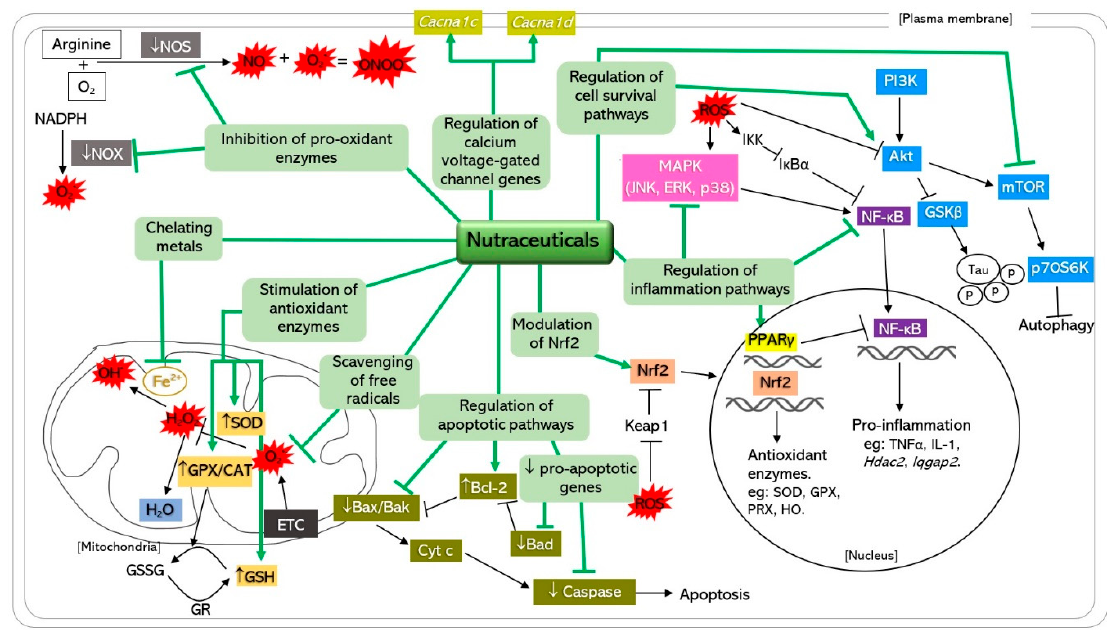
Figure 1 . The proposed mechanism of action of nutraceutical in alleviating neurodegenerative disease.